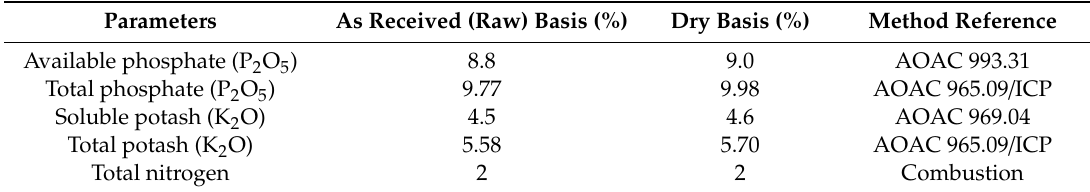
Table 3. Summary of fly ash composition